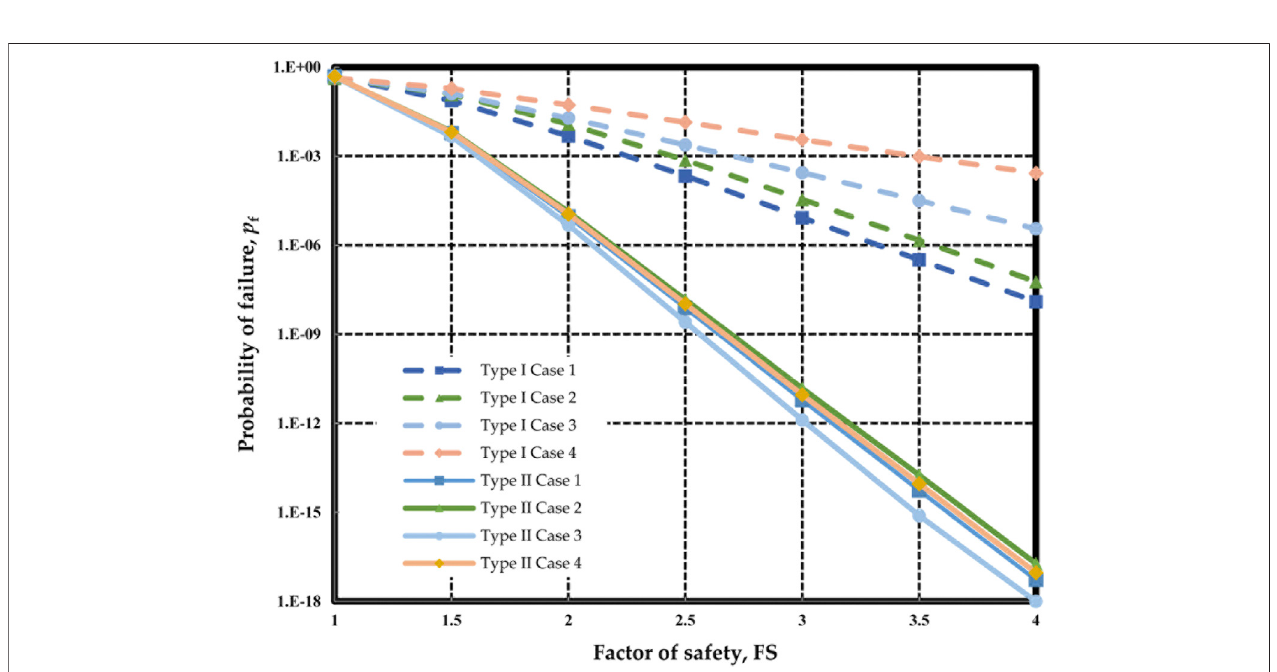
FIGURE 7 | FS – P f relationships for Nanjing sites.